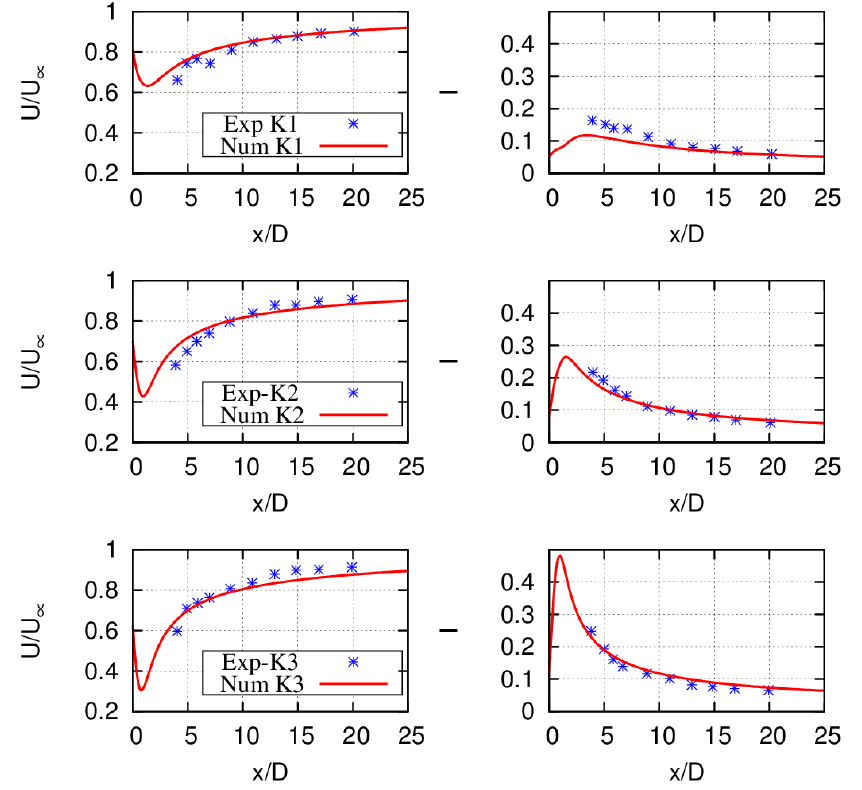
Figure 2. Axial normalized velocity ( left ) and turbulence intensity ( right ) along the turbine’s axis (x = 0 is the AD position). Comparison between experimental (Exp) (Harrisson et al., 2010) [40] and numerical results (Num) for the 3 values of K tested (cf. Table 1). Note that, to evaluate the turbulence intensity (IT) in the wake of the AD, Equation (10) was applied by using the local maximal velocity to dimensionless the turbulent kinetic energy.